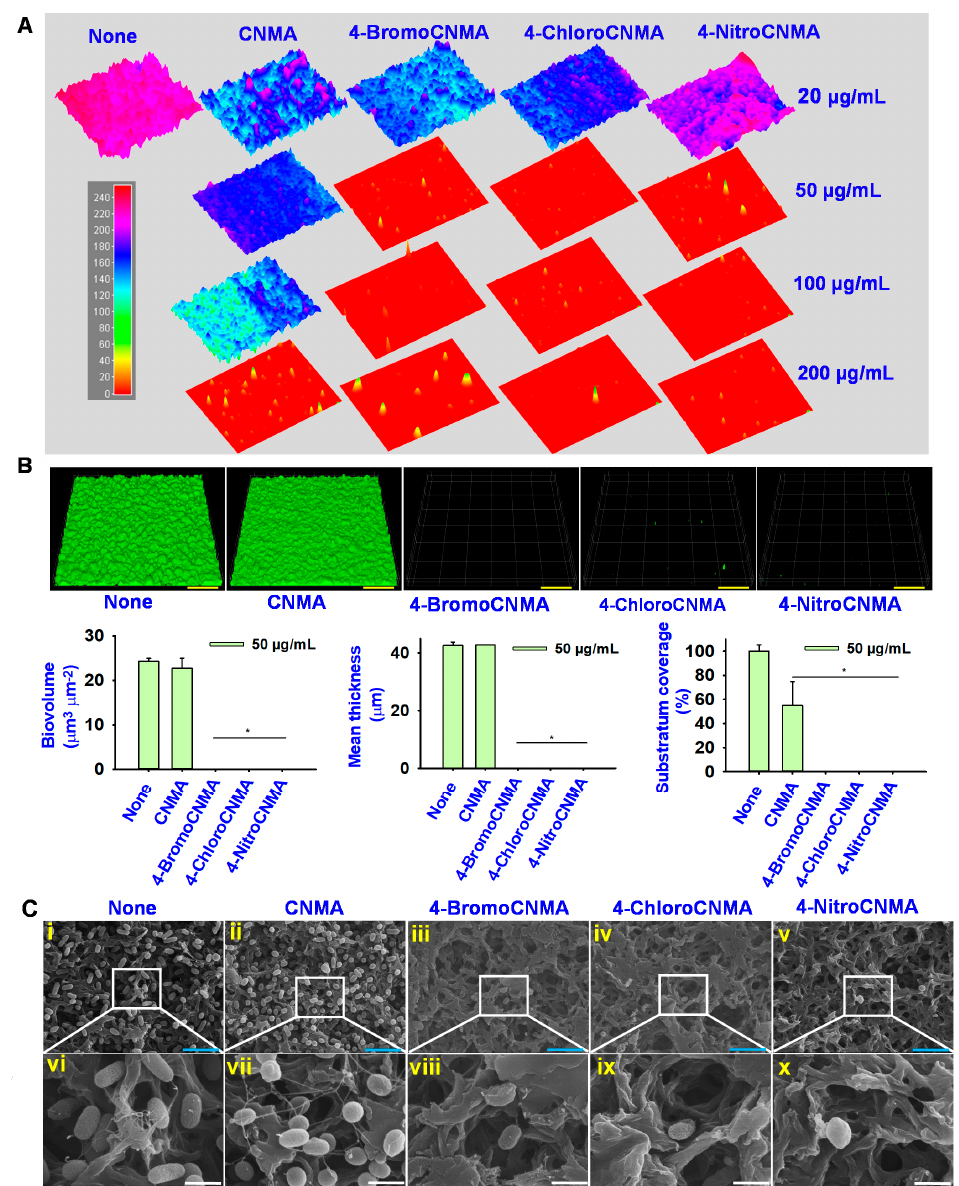
Figure 2. Antibiofilm activity of three selected CNMA derivatives. Three-dimensional optical microscopy images of biofilm formation with/without treatment ( A ), CLSM and COMSTAT analysis of biofilm images with or without 50 µg/mL of CNMA, 4-BromoCNMA, 4-ChloroCNMA, and 4-NitroCNMA ( B ). The yellow bar represents 100 µm. SEM images showing the effects of CNMA derivatives on cell and biofilm morphology ( C ). The blue and white scale bars are 6 and 1.5 µm, respectively. * denotes a significant difference at p < 0.05.